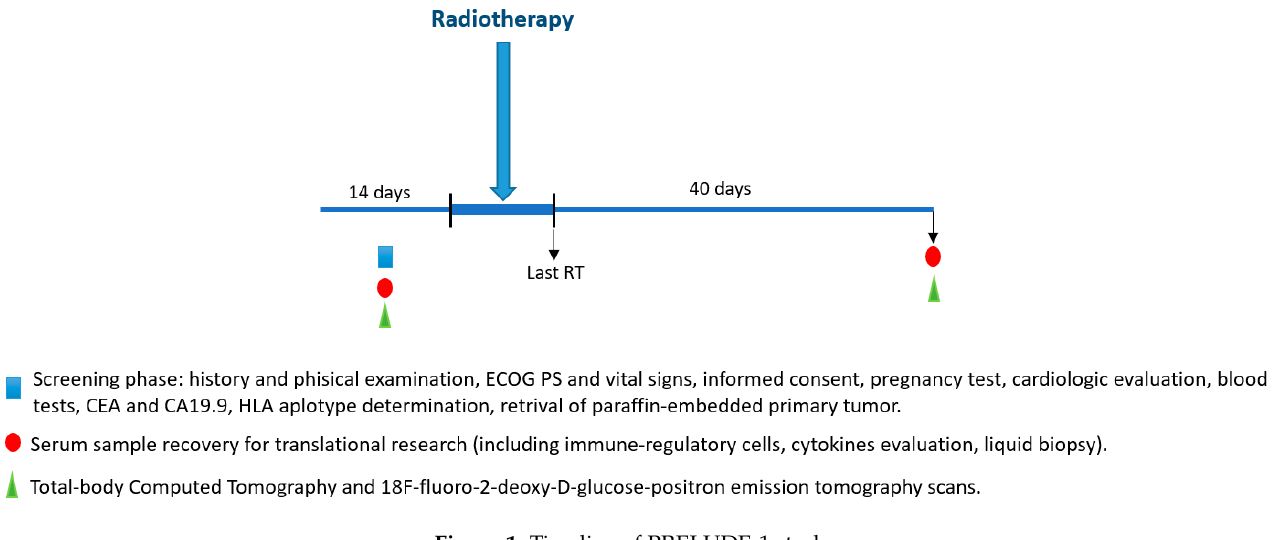
Figure 1. Timeline of PRELUDE-1 study. Table 1. Schedule of assessments for PRELUDE-1 study.